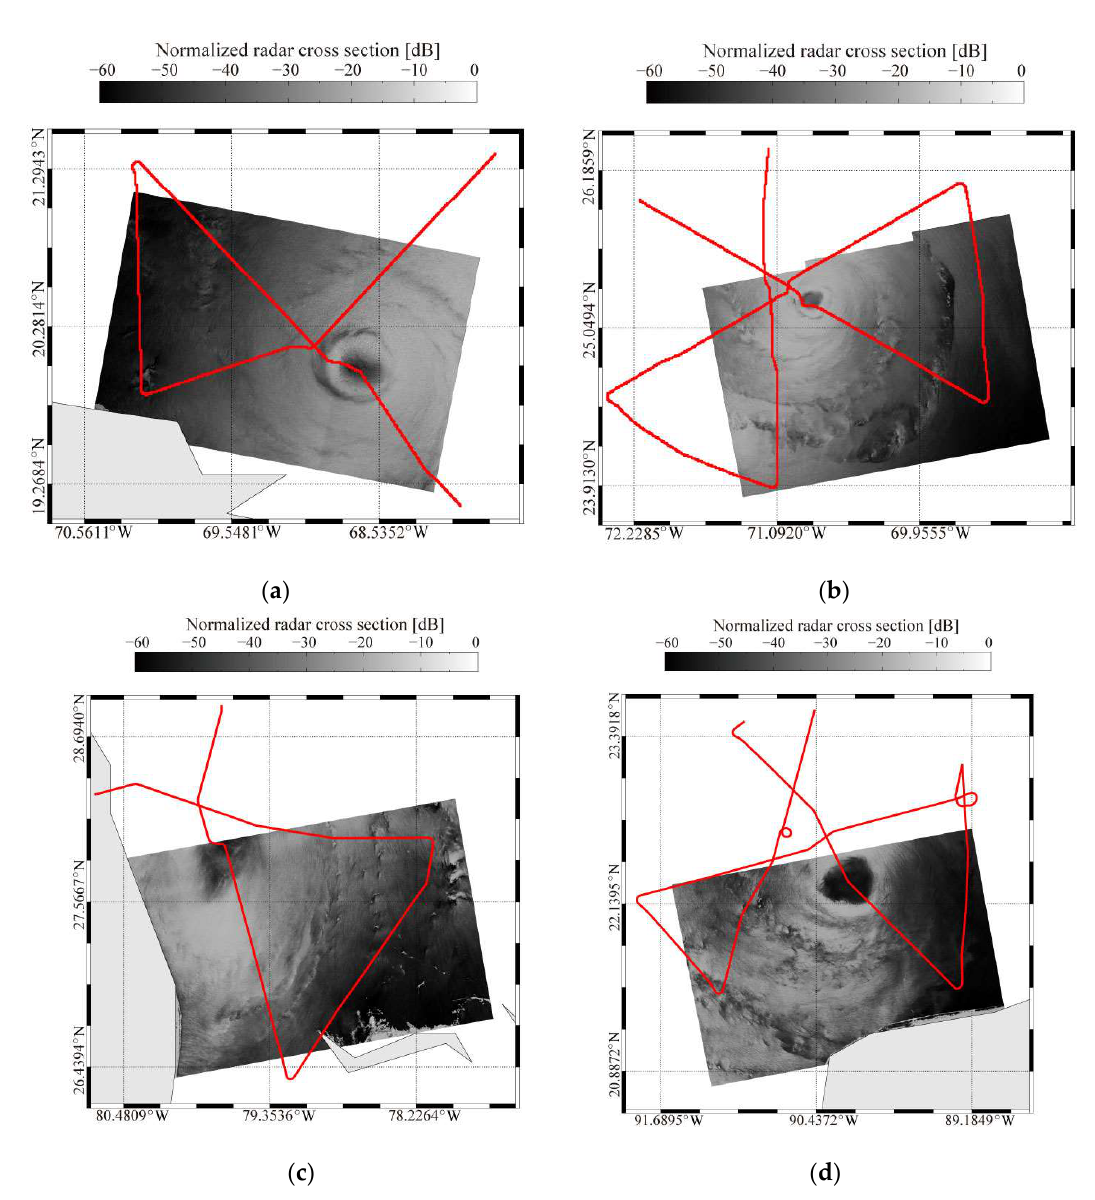
Figure 1. VV-polarized normalized radar cross section (NRCS) images relevant to the Sentinel-1 (S-1) synthetic aperture radar (SAR) dataset collected over the tropical cyclones (TCs): ( a ) Irma; ( b ) Dorian; ( c ) Lsaias and ( d ) Delta. The red lines represent the he Stepped-Frequency Microwave Radiometer (SFMR) tracks provided by the National Oceanic and Atmospheric Administration aircraft.